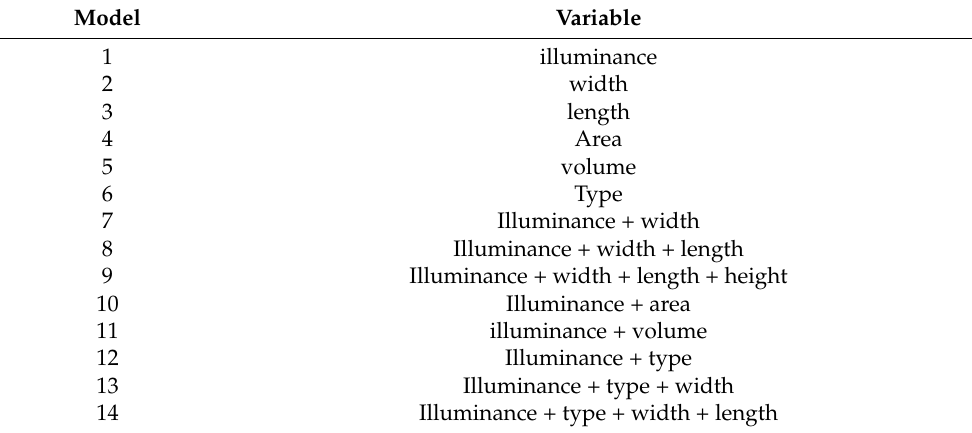
Table 2. Variables included in the 14 linear regression models that we compared to evaluate the automated method we developed to extract interior